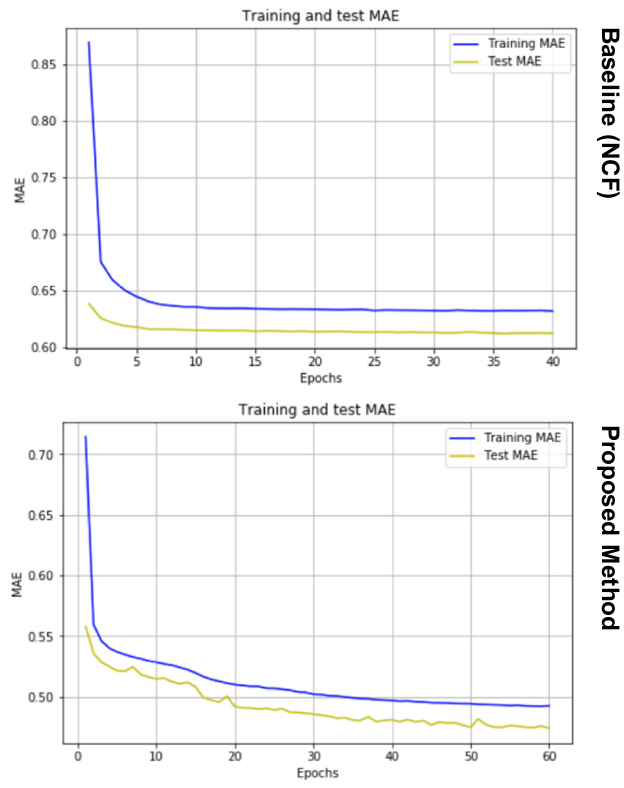
Figure 5. MovieLens . Mean Absolute Error (MAE) obtained by training both the NCF baseline (top chart) and the proposed RNCF neural architecture (chart below). Training and testing evolutions for the 60 first epochs (x-axis).